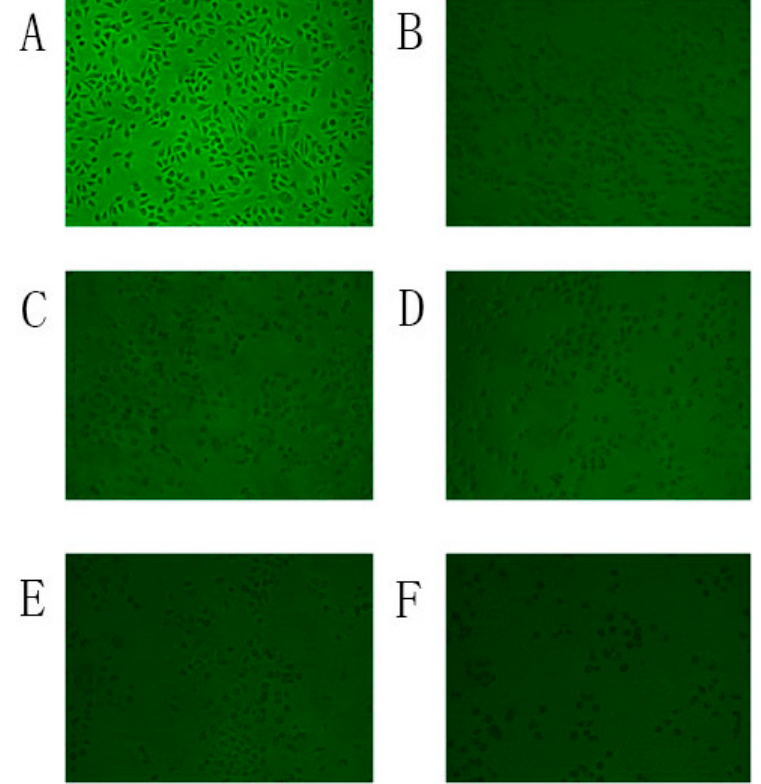
Figure 4. Morphological changes in BGC823 cells. The cells were treated with 4d ( A ) Control; ( B ) 12.5 µ M; ( C ) 25 µ M; ( D ) 50 µ M; ( E ) 100 µ M; ( F ) 200 µ M for 48 h and observed under a phase contrast